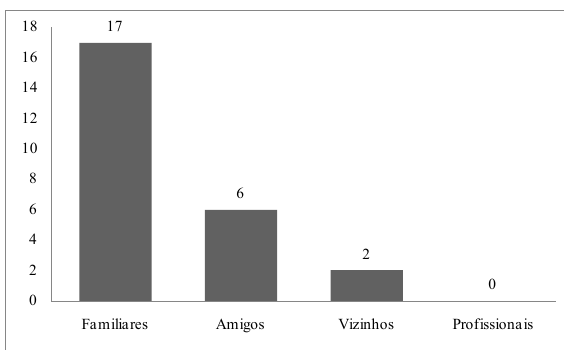
Figura 1 . Fontes de apoio das mães de acordo com o tipo de